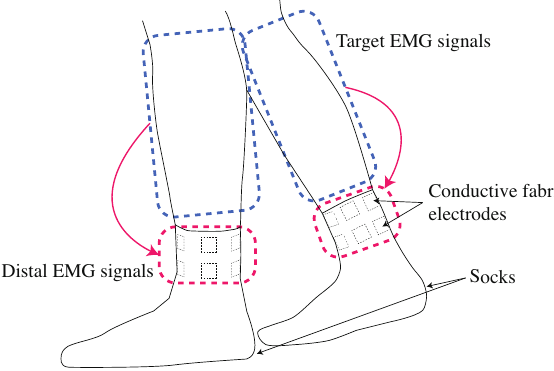
Figure 1. Design of socks that measure distal EMG signals propagated target